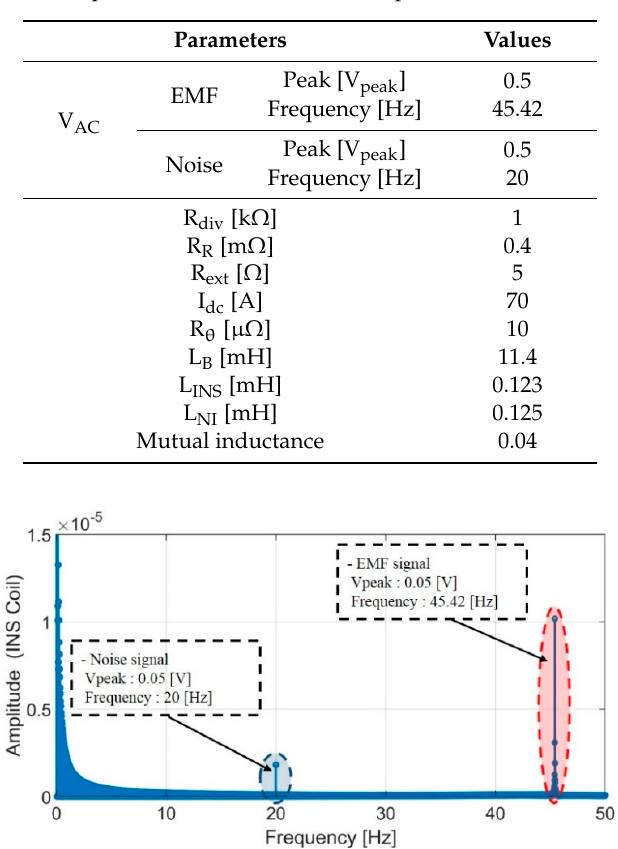
Figure 7. FFT analysis results using the not-insulated (NI) coil.